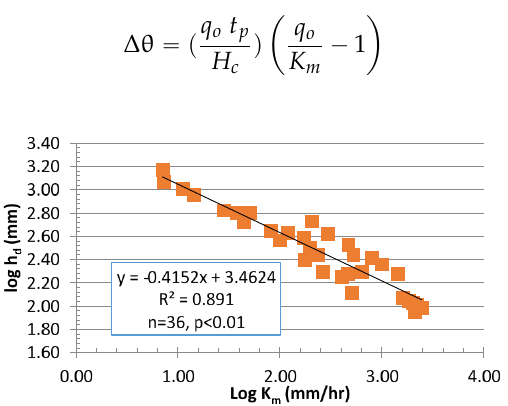
Figure 1. Relationship between field-saturated hydraulic conductivity, K m , and displacement pressure head, h d , for fine sands (data taken from Grismer, [19]).